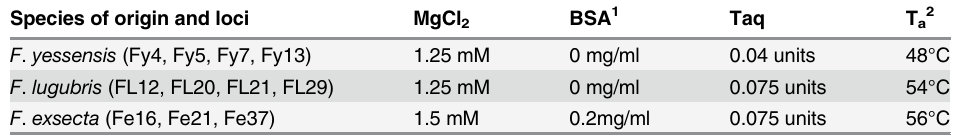
Table 1. Variations in PCR conditions microsatellite loci using 10ul reaction volumes. Species of origin and